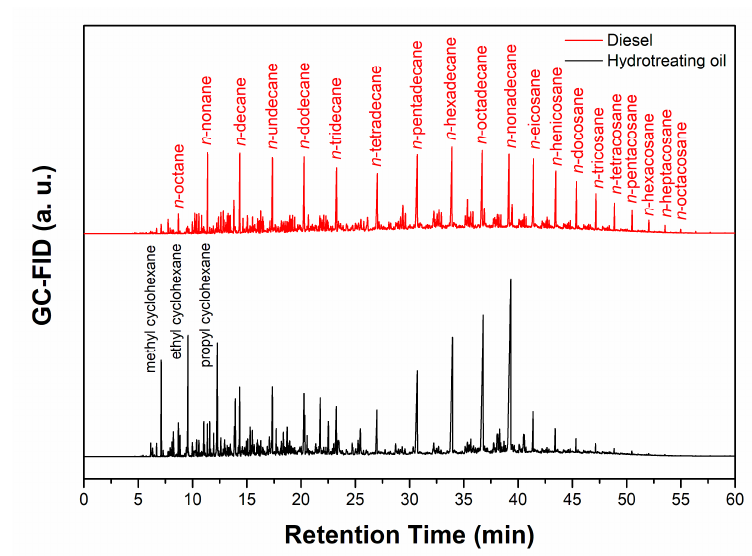
Figure 5. GC profiles of diesel and hydrotreating oil, which is produced by deep hydrotreating of middle distillates over sulfide NiMo / γ -Al 2 O 3 catalyst at 350 ◦ C and 7 MPa of H 2 for 5 h.